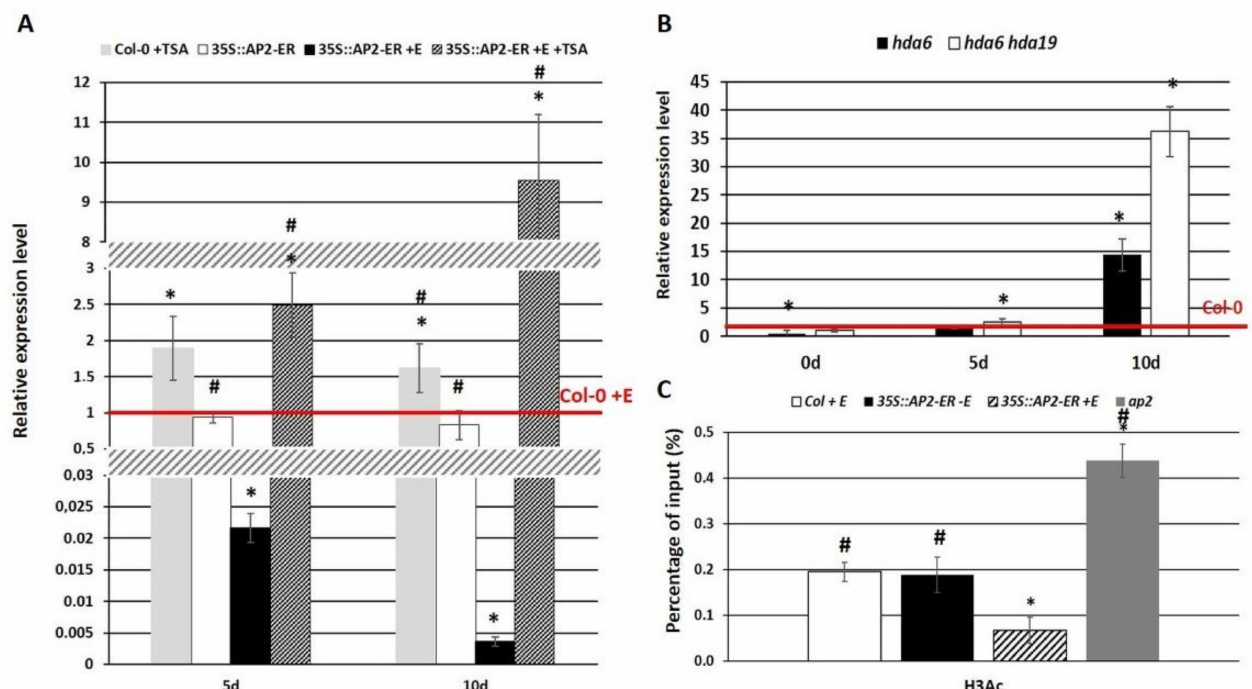
Figure 6. A Hac-related mechanism is involved in the AP2-mediated repression of WUS during SE. Expression analysis of WUS in the SE culture in the AP2 -overexpression line untreated (-TSA) and the one that had been treated (+TSA) with TSA (trichostatin A) ( A ) and the hda6 and hda6 hda1 9 mutants ( B ). Hac enrichment in the chromatin fragment that was bound to the TSS + 300 bp region of the WUS gene promoter in the explants of Col-0 (WT), 35S:: AP2 -ER and ap2 ( C ). AP2 overexpression was induced with β -estradiol (+E). The HDAC activity was inhibited by the TSA treatment in the Col-0 control (Col-0 + TSA) and in the AP2 -overexpressing (35S:: AP2 -ER +TSA) culture. The relative transcript level was normalized to an internal control ( At4g27090 ) and calibrated to the WT (Col-0) culture of the same age (0 d, 5 d, and 10 d). * values significantly different from the Col-0 culture of the same age ( p < 0.05; n = 3 ± SD); #—values significantly different from the 35S:: AP2 -ER + E culture of the same age ( p < 0.05; n = 3 ±